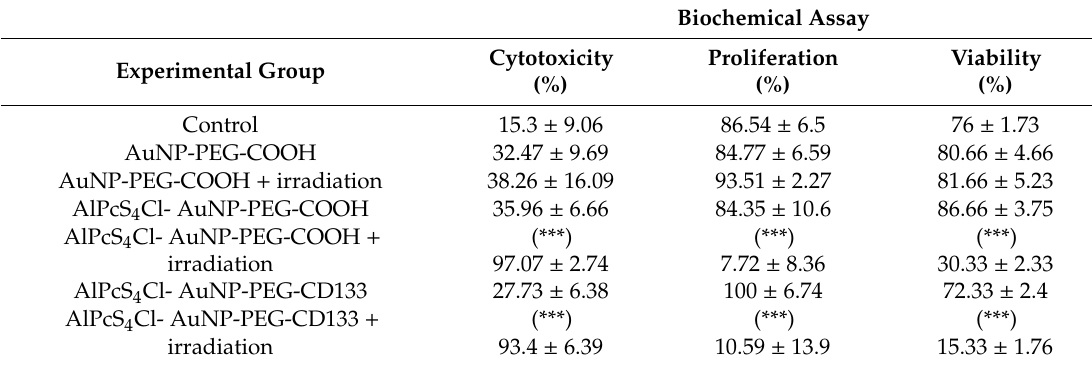
Table 4. Biochemical evaluation of the NBC photodynamic e ff ects in lung CSCs 24 h post-irradiation. A statistically significant increase in cytotoxicity and decrease in proliferation and viability was seen post-irradiation, using AlPcS 4 Cl-AuNP-PEG-COOH and AlPcS 4 Cl-AuNP-PEG-CD133 ( p < 0.001(***)). Biochemical